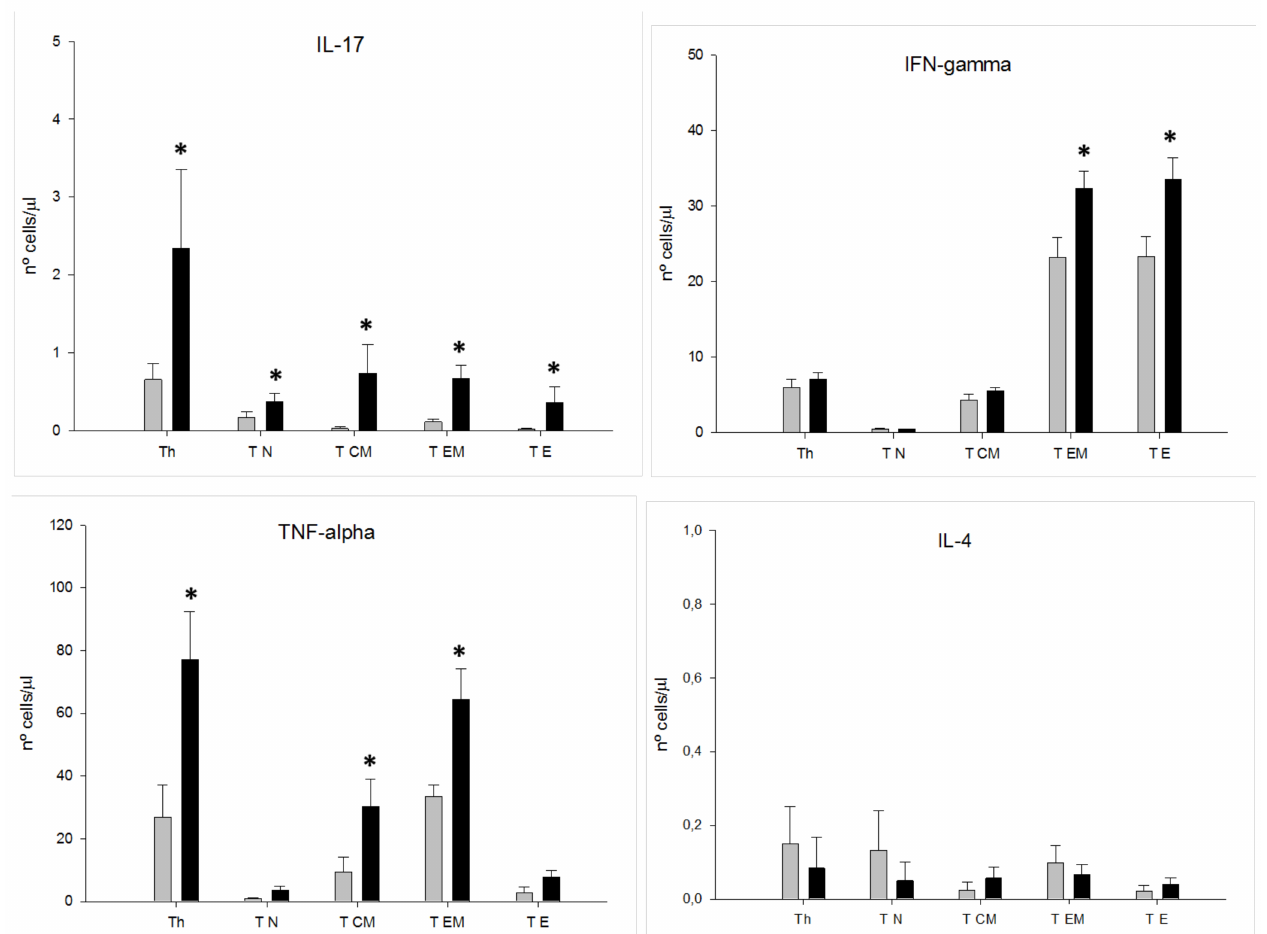
Figure 3. Circulating CD4 + T lymphocytes and T N , T CM , T EM and T E subsets that are able to express IL-17A, IFN γ , TNF-alpha, and IL-4 in MDD patients and HCs. Absolute number (cells/ µ L) (y axis that are able to express the indicated cytokine by total CD4 + T lymphocytes and their T N , T CM , T EM and T E subsets (x axis)) in MDD patients (black rectangles plots) and HCs (gray rectangles plots). * Significant difference between MDD and HCs for the indicated